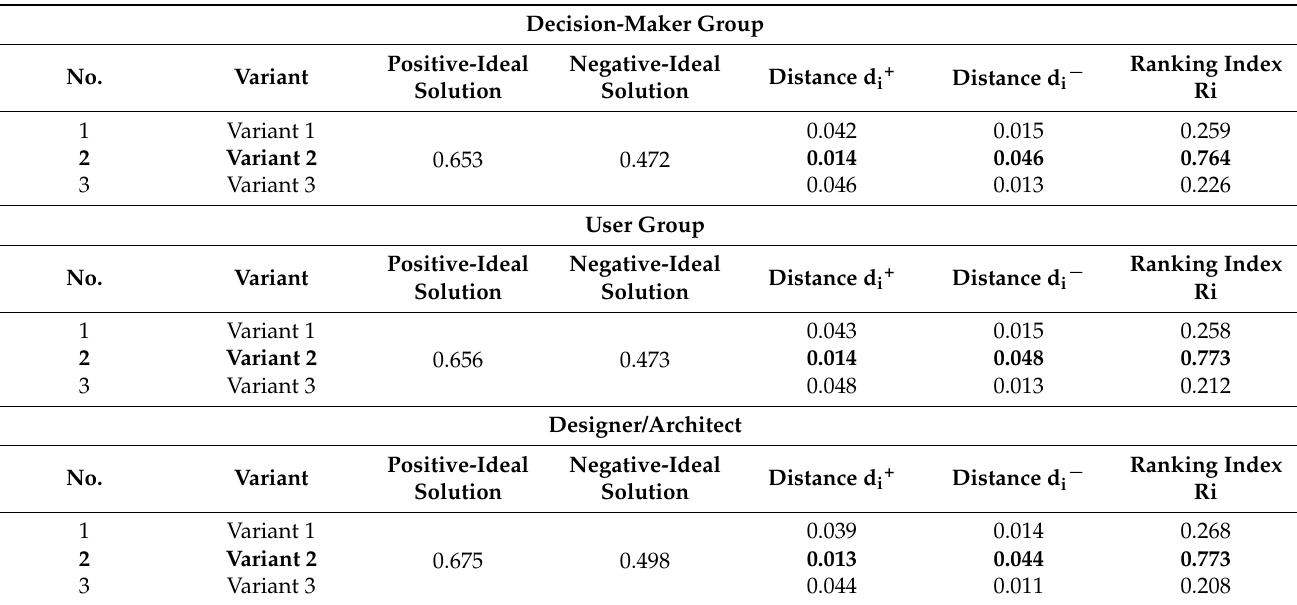
Table 13. Positive-ideal and negative-ideal solutions for individual groups of decision-makers, distances of the analyzed variants from the positive-ideal and negative-ideal solutions, and ranking factors.